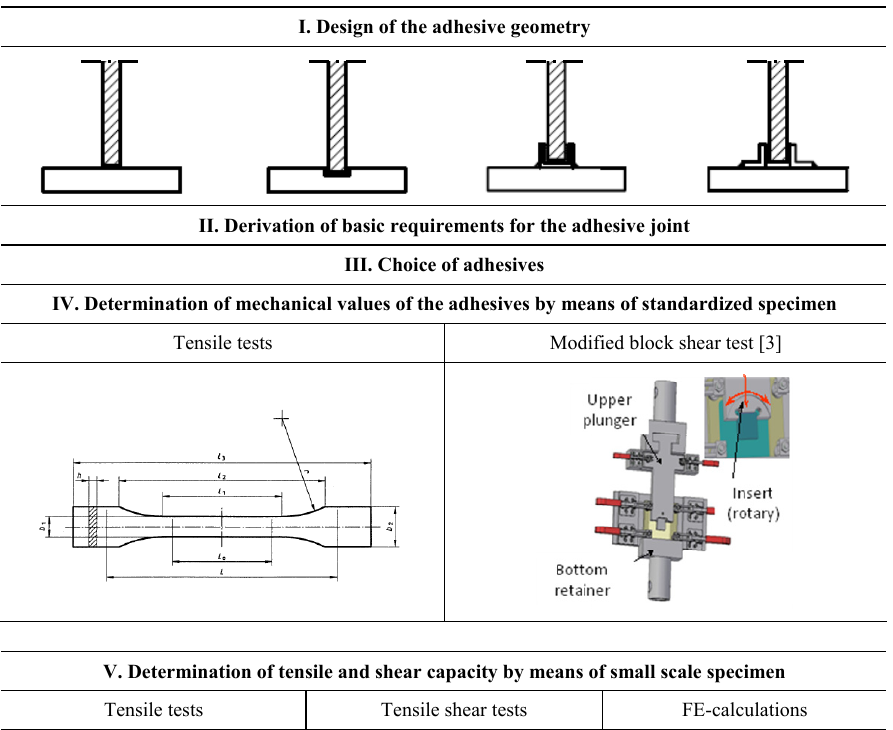
Table 1: Overview of the systematic approach for the development of design